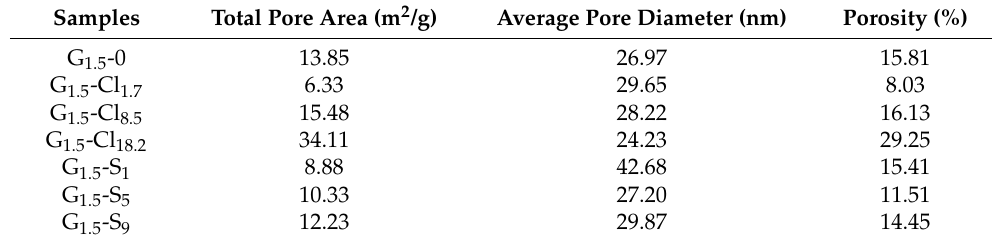
Table 1. Geopolymer pore parameters based on MIP